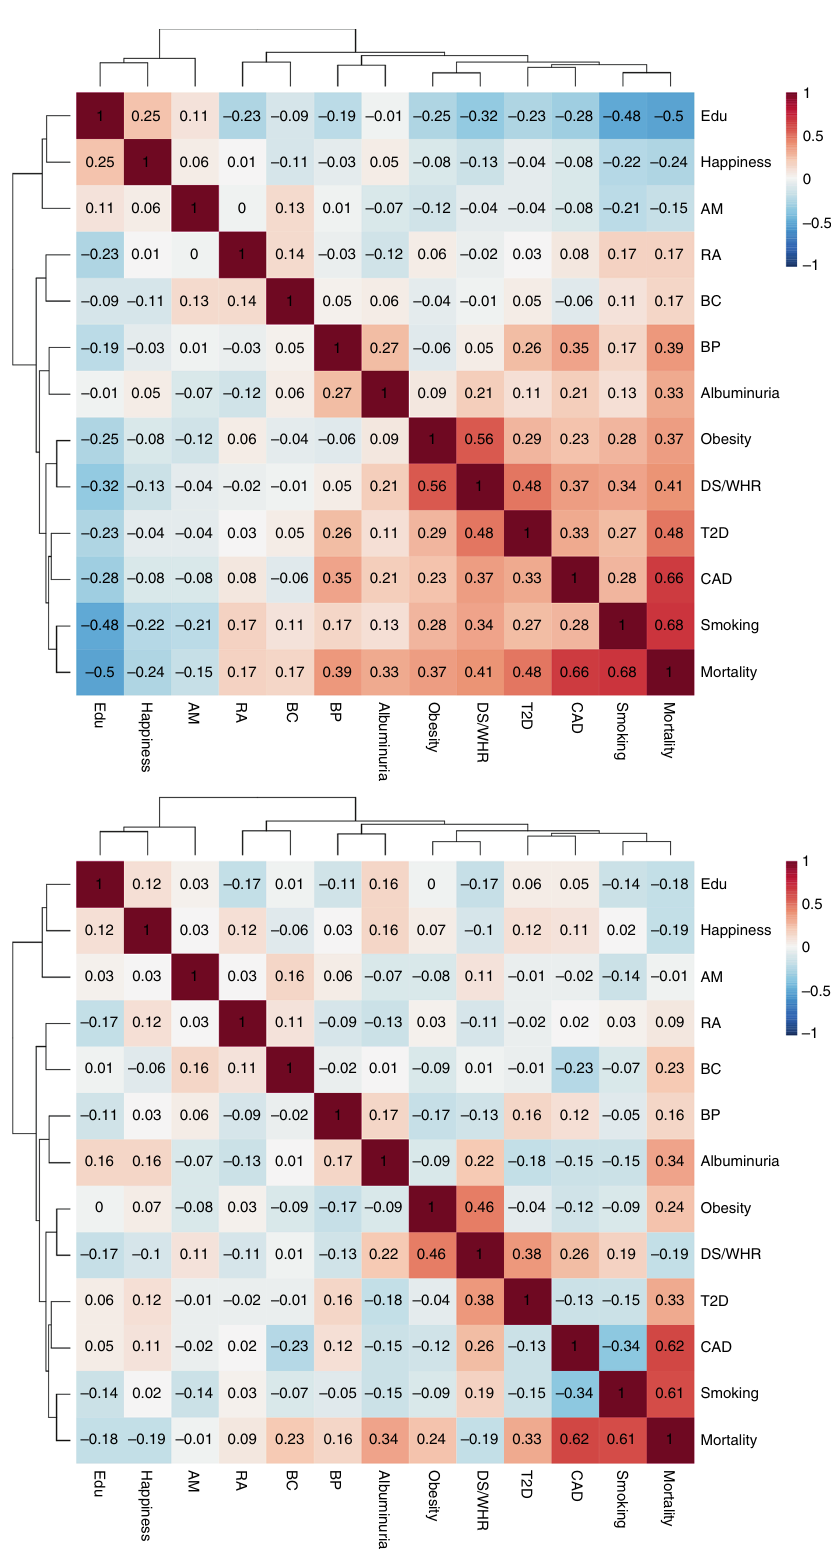
Fig. 5 Genetic correlations between trait clusters that associate with mortality. The upper panel shows whole genetic correlations, the lower panel, partial correlations. T2D, type 2 diabetes; BP, blood pressure; BC, breast cancer; CAD, coronary artery disease; Edu, educational attainment; RA, rheumatoid arthritis; AM, age at menarche; DL/WHR Dyslipidaemia/Waist-Hip ratio; BP, blood